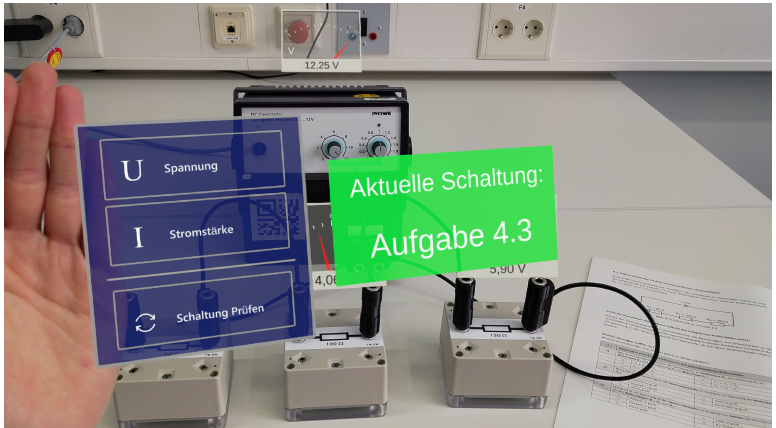
Figure 9. Screenshot of the menu attached to the hand of the participant. The visible options are Spannung (voltage), Stromstärke (current), and Schaltung prüfen (check circuit). As the participant has just checked the circuit, the green window indicates a valid circuit and displays Aufgabe 4.3 (task 4.3) to confirm the task matching the current circuit setup.